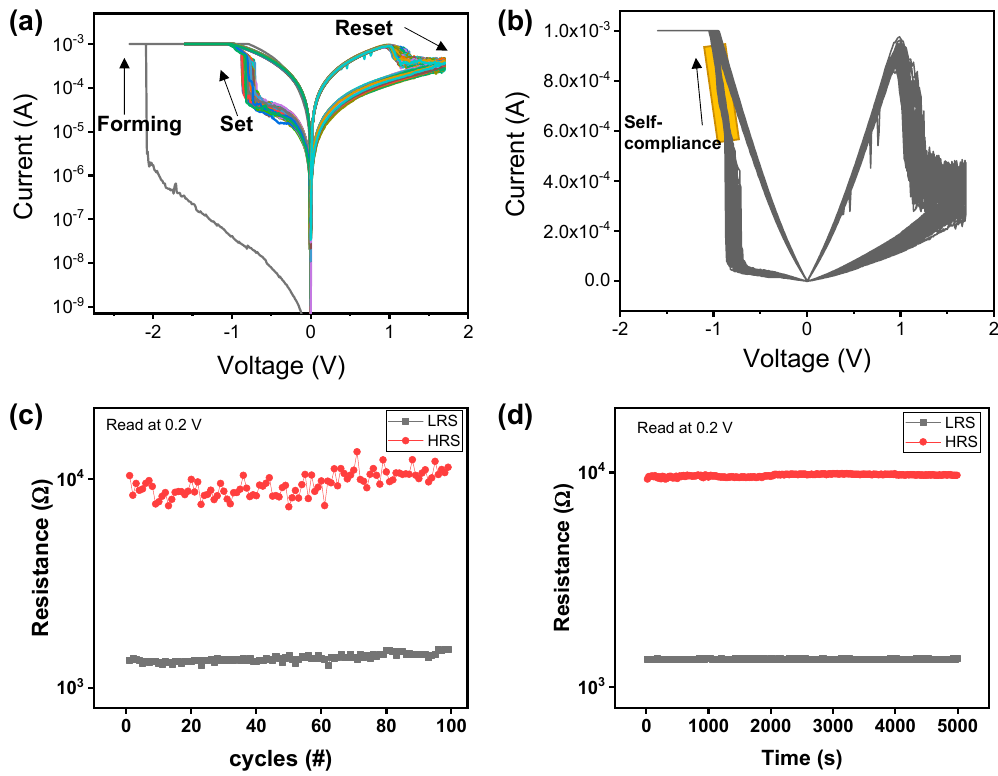
Figure 2. Basic electrical measurement of the Pt/HfO 2 /TaN device for the memory device characteristics. I–V curves include the forming, set, and reset processes in ( a ) log scale and ( b ) linear scale. ( c ) endurance and ( d ) retention.